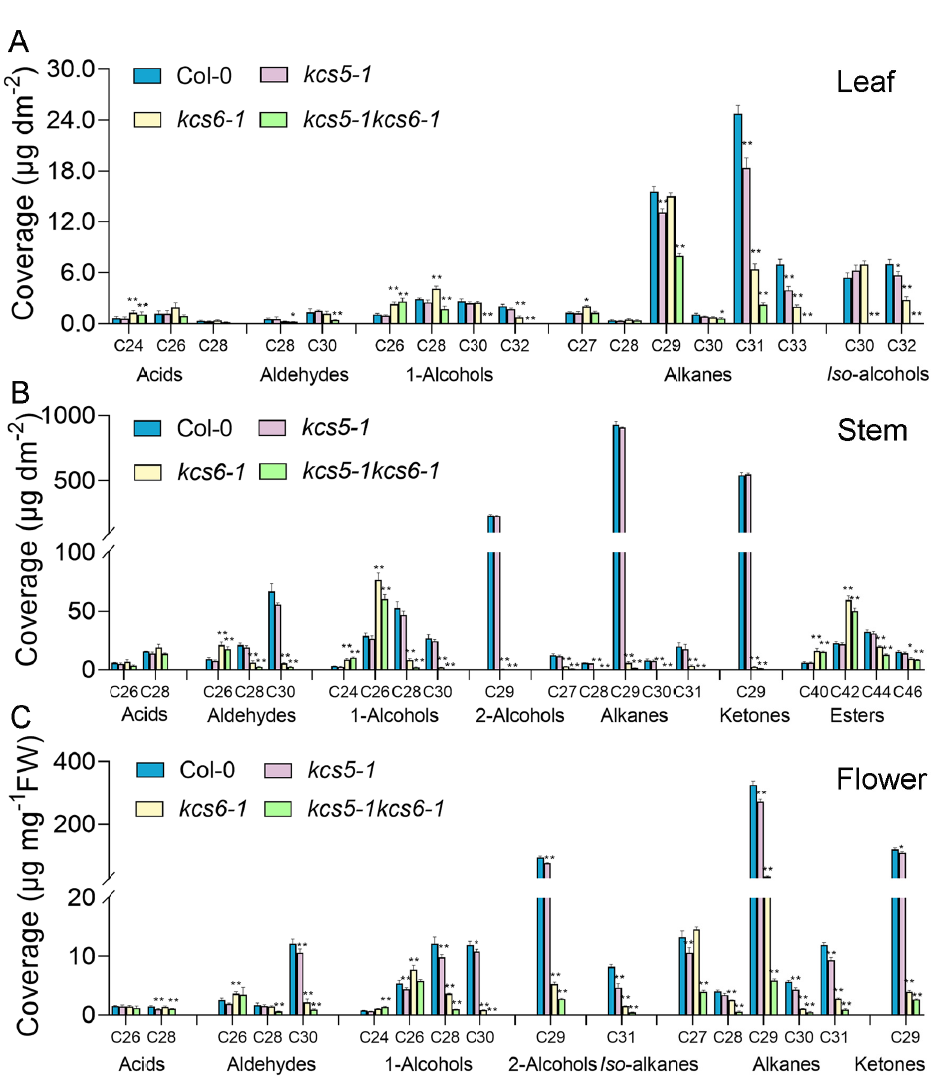
Figure 4. Wax profile in different organs of different plants. Rosette leaves ( A ), stems ( B ), and flowers ( C ) of Col-0 , kcs5-1 , kcs6-1 , and kcs5-1 kcs6-1 were collected for wax analysis. Wax coverage is expressed as wax amounts per leaf surface area ( µ g.dm − 2 ). Each wax constituent was designated by carbon chain length and was labeled by chemical class along the x-axis. The values shown are means ± SD ( n = 4). * p < 0.05; ** p <